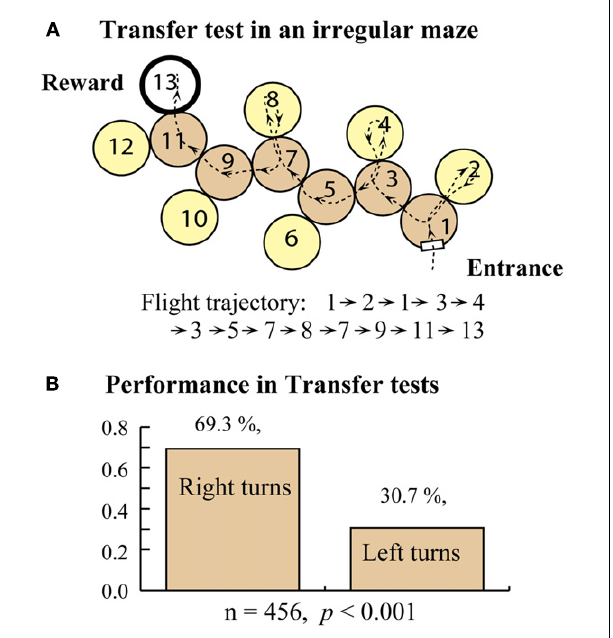
Table 2 | Summary of maze performance as evaluated by flight time. FIGURE 6 |Training in a right turn maze and transfer test in an irregular